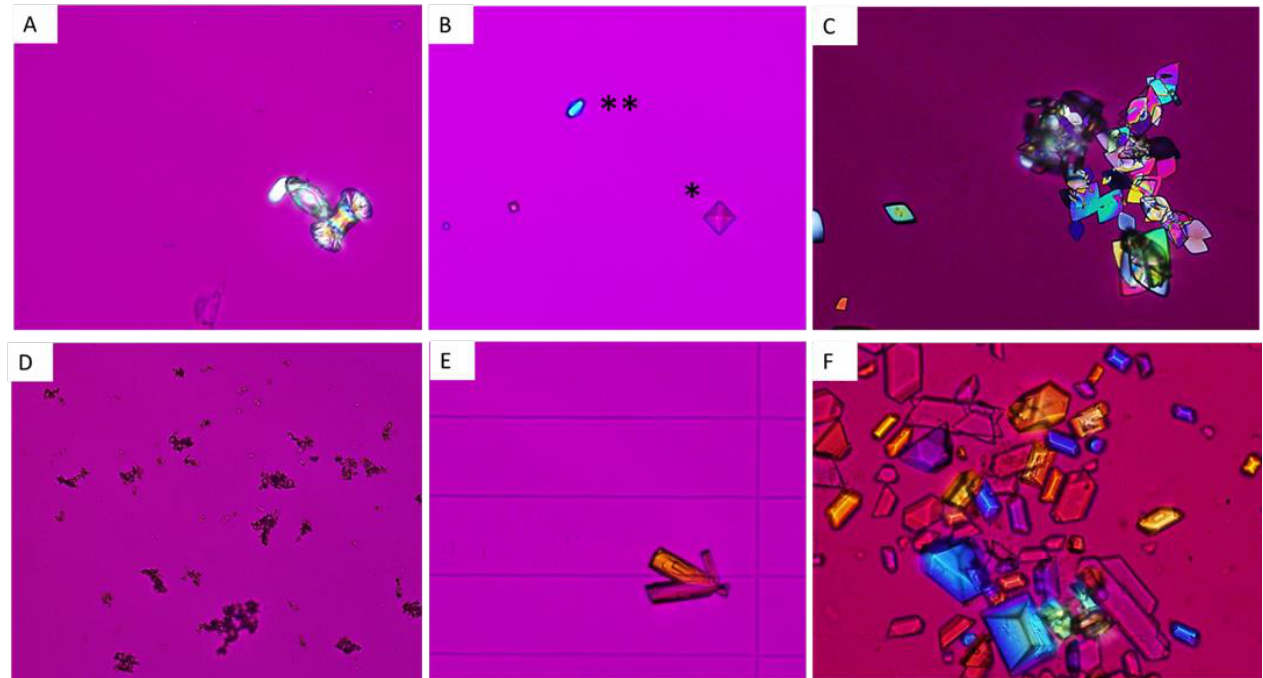
Figure 6. Crystalluria: “metabolic” urine crystals. ( A ) Calcium oxalate monohydrate crystals with a dumb bell aspect. ( B ) Calcium oxalate dihydrate crystals, with both frequent octahedral (*) and dodecahedral shapes (**), which are typical features of hypercalciuria. ( C ) Uric acid dihydrate crystals in an acidic urine. ( D ) Amorphous or poorly crystallized calcium phosphates in a relatively “alkaline” urine. ( E ) Brushite crystals, typical features of hypercalciuria associated with increased urine phosphate excretion. ( F ) Struvite crystals in an alkaline urine, due to urea-splitting bacteria.